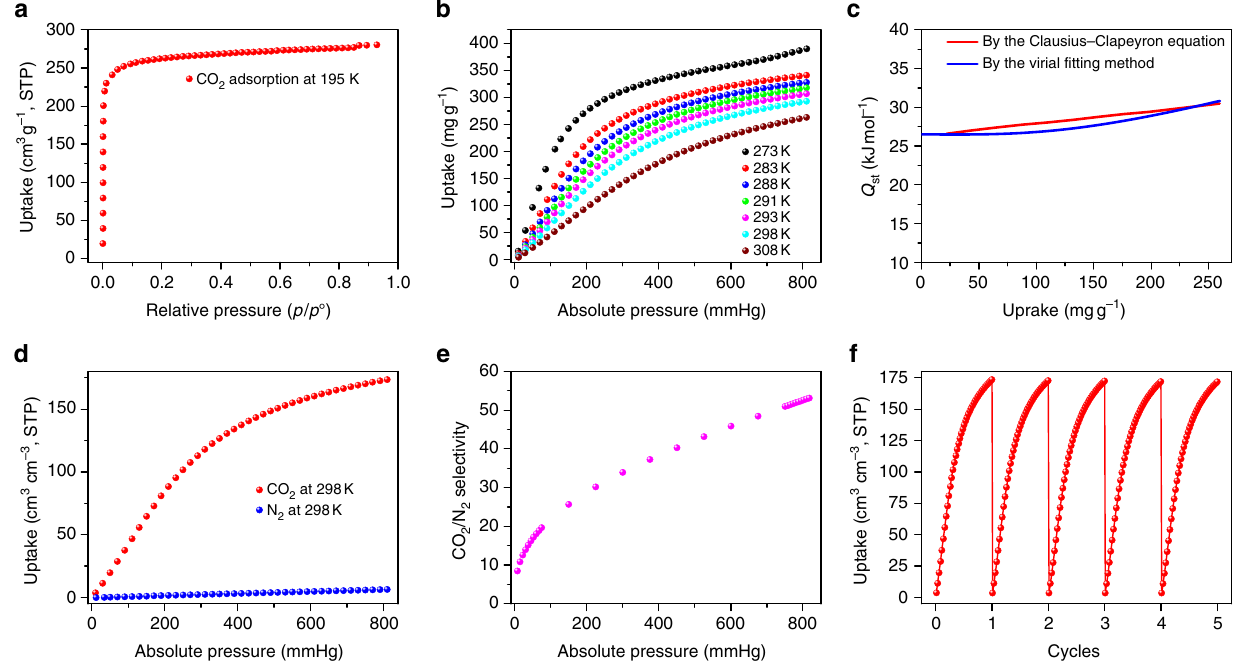
Fig. 3 Experimental CO 2 adsorption by FJI-H14. a CO 2 adsorption isotherm for FJI-H14 at 195 K. b CO 2 adsorption isotherm for FJI-H14 at 273, 283, 288, 291, 293, 298 and 308 K. c The isosteric heat of CO 2 adsorption ( Q st ) for FJI-H14 calculated by the Clausius – Clapeyron equation and the Virial fi tting method. d N 2 and CO 2 adsorption isotherms for FJI-H14 at 298 K. e CO 2 /N 2 selectivity for the 15/85 CO 2 /N 2 mixture at 298 K. f Cycles of CO 2 adsorption for FJI-H14 at 298